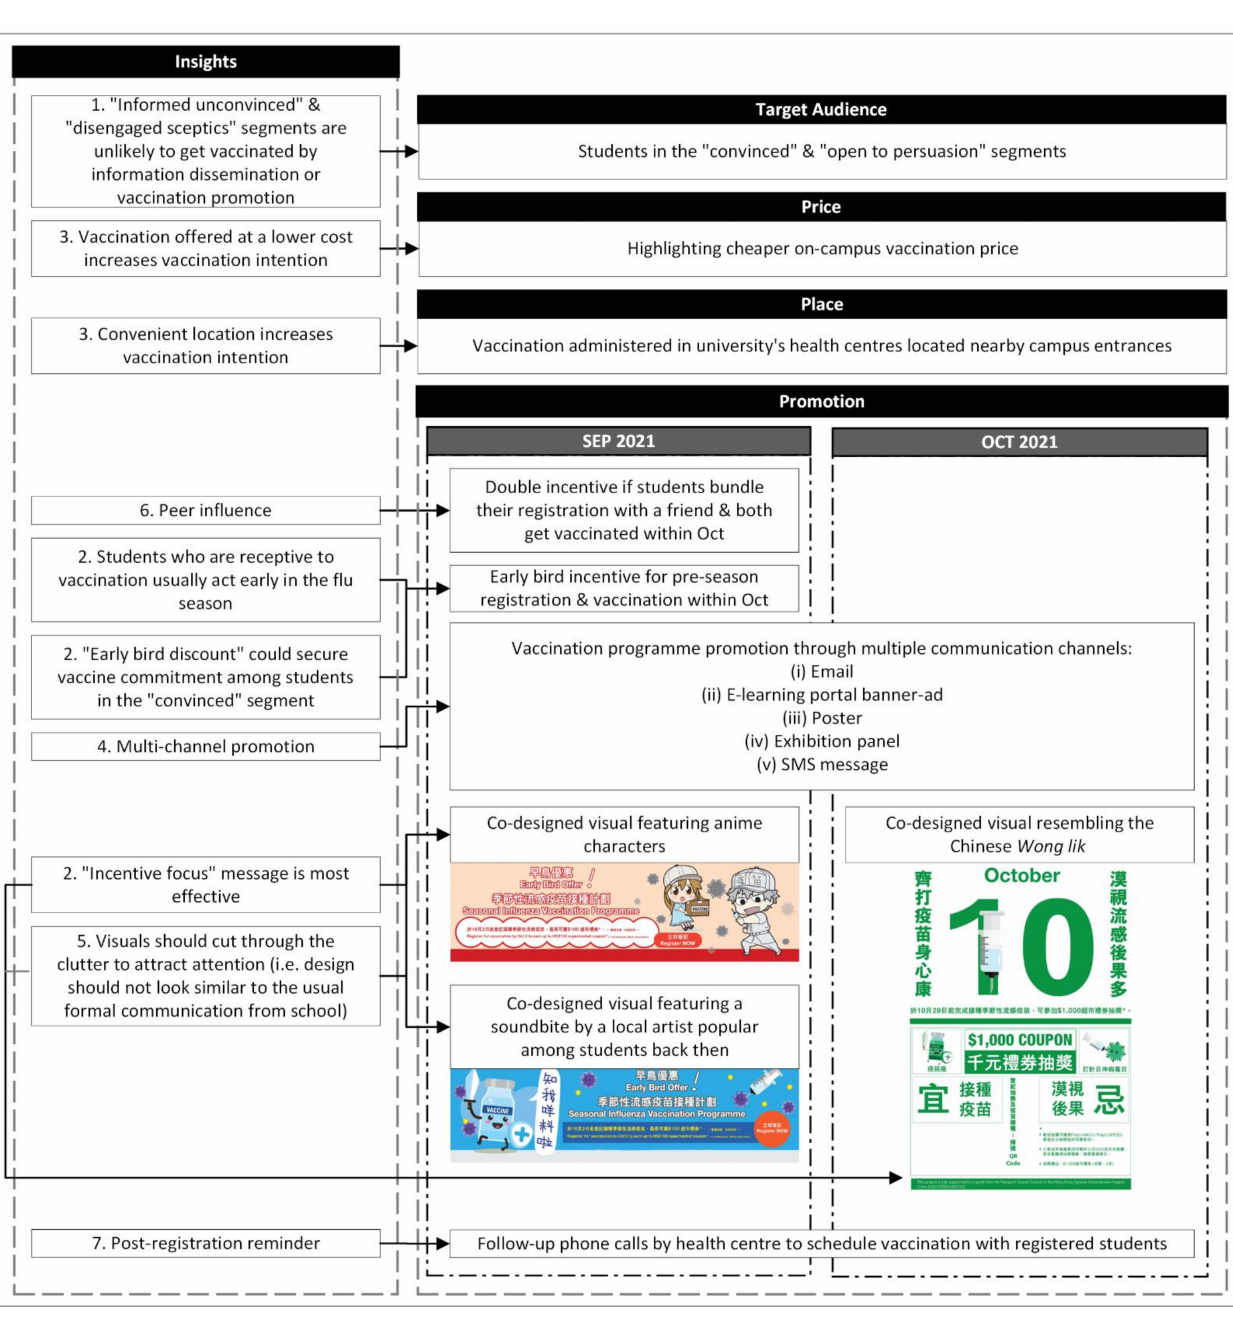
Figure 2. Illustration of how the marketing-mix was built based on insights. Remarks: The numbers shown in front of each insight refer to the insights summarized in Section Insight